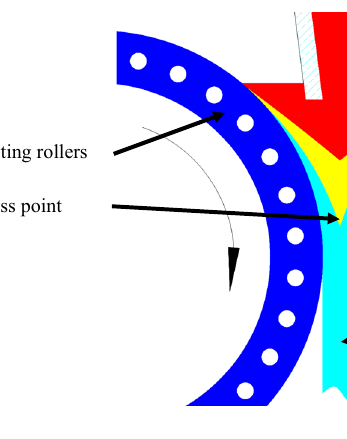
Figure 1: The twin - roll strip casting